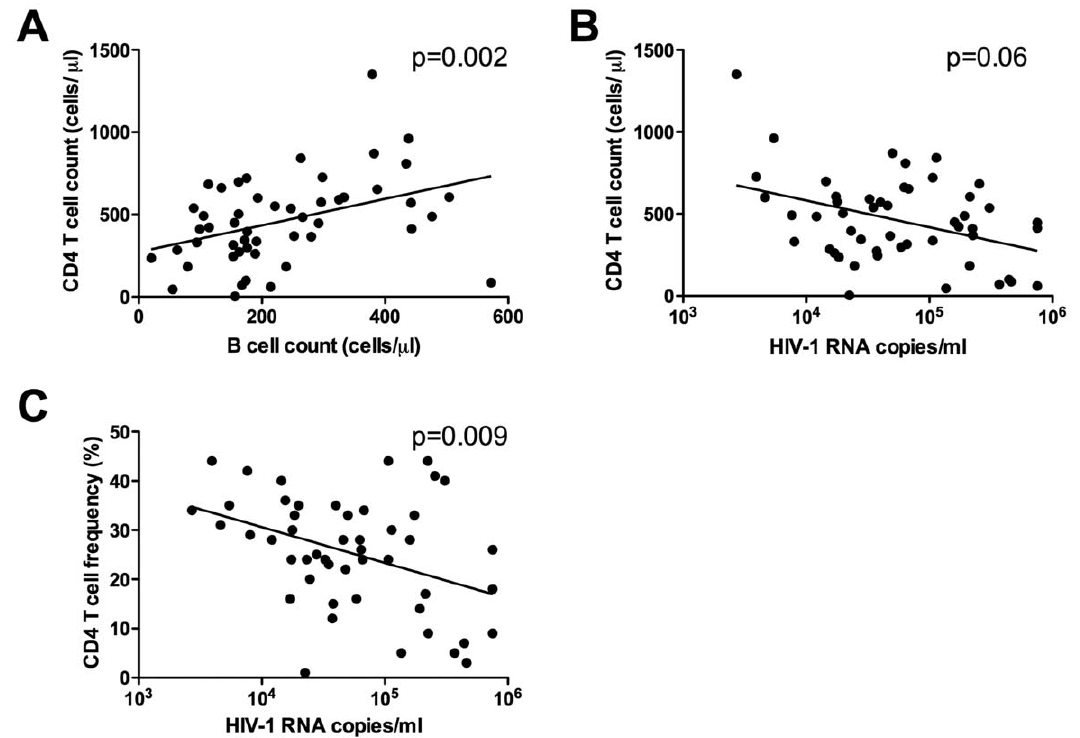
Figure 2. Absolute CD4 + T lymphocyte counts correlate with B lymphocyte absolute counts, but not with HIV-1 viral Load. The absolute counts of B lymphocytes correlated with the absolute number of CD4 + T lymphocytes (A). The number of plasma HIV-1 RNA copies/ml showed a significant inverse correlation with the CD4 + T lymphocyte percentage (C) and a trend towards correlation with CD4 absolute number (B).